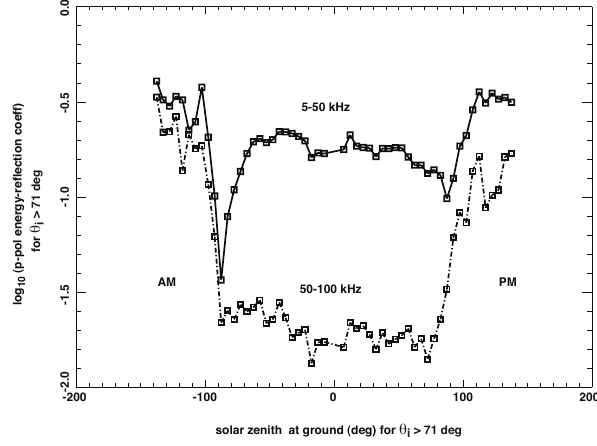
Fig. 6. Median log 10 (energy reflectivity) vs. solar zenith angle in the most grazing angles of incidence, 71 <θ i < 74 deg (the red points in Fig. 5). The signed-zenith range from − 140 to +140 deg is di- vided into 56 bins, each 5-deg-wide. In zenith bins having > 100 data points, we take the median of the energy-reflection coefficient. This median is shown for low band (solid curve) and high band (dashed curve.) The negative values of Z are for rising sun (AM), the positive for falling sun